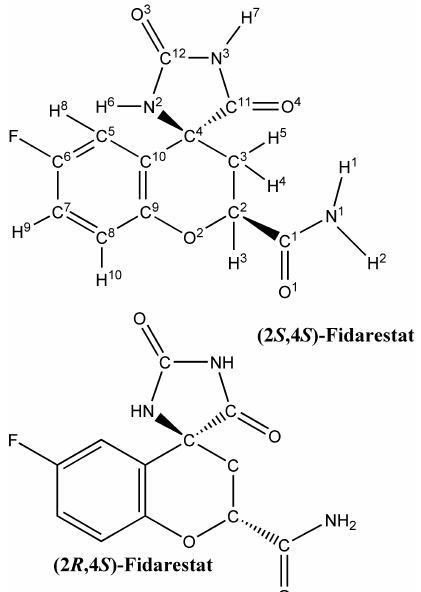
Figure 1 . Structures and nomenclatures of (2S,4S)-Fidarestat and (2R,4S)-Fidarestat. The